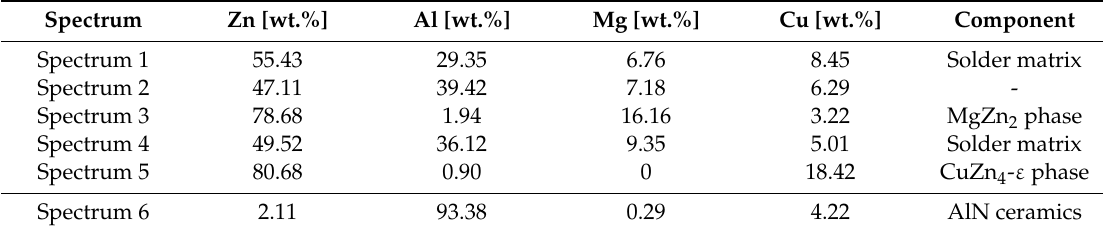
Figure 15. The EDX analysis of the AlN/Zn–Al–Mg joint boundary (marked AlN ceramics). Table 5. The phase composition results of AlN/Zn-Al-Mg joint boundary. Spectrum